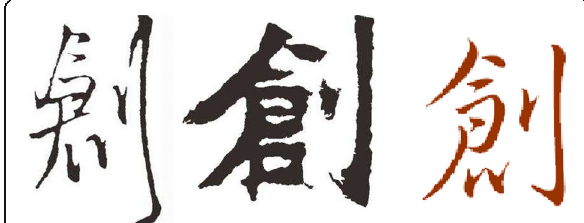
Fig. 2 Sample selection of different fonts and different colors